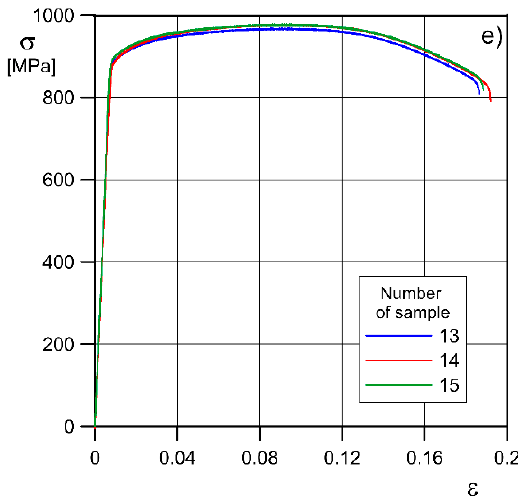
Figure 5. Monotonic tensile testing of Ti6Al4V titanium alloy specimens printed with LPBF method with porosities: ( a ) 81%; ( b ) 73%; ( c ) 50%; ( d ) 34%; ( e ) near 0, where: σ —nominal axial stress, ε —nominal strain (both effective). Table 3. Effective strength properties of Ti6Al4V sintered titanium alloy of different porosities produced by the LPBF method compared with the values for solid material specified by the producer. Sample